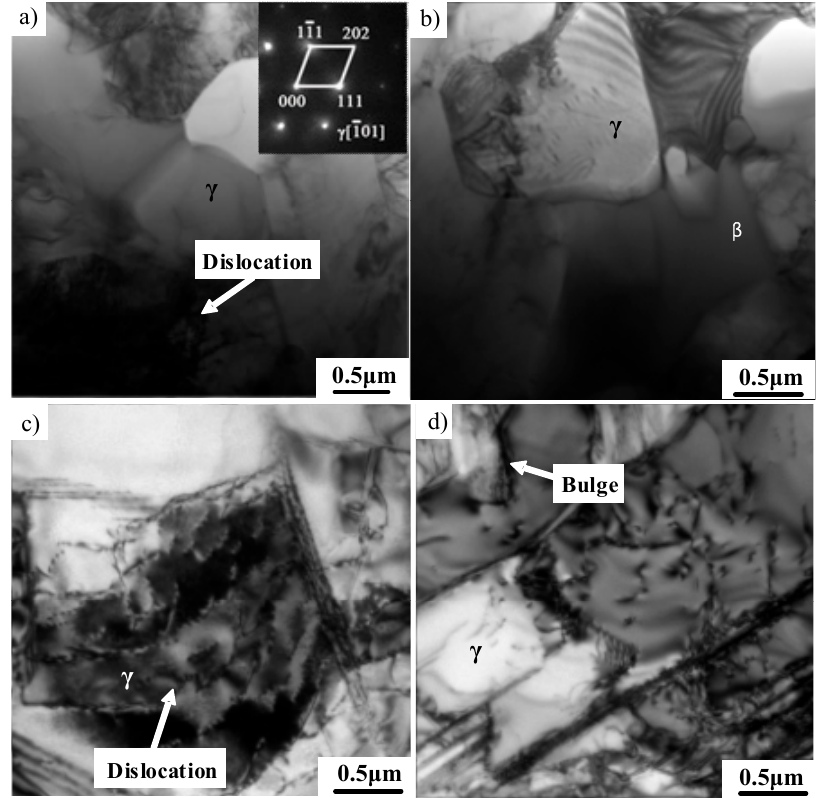
Figure 8. TEM images showing the microstructure of the alloy after 40% deformation. ( a ) Recrystallized γ grains, ( b ) the coexistence of the γ and β phases, ( c ) dislocations, ( d ) sub-boundaries.